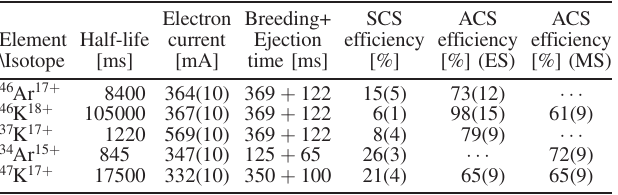
TABLE III. Single charge state (SCS) and all-charge-state (ACS) efficiencies of rare-isotope beams reaccelerated to nu- clear-physics experiments. The ACS efficiencies were measured at two locations: at the energy slit (ES) before the Q=A separator ’ s magnet and at the mass slit (MS) after the magnet.